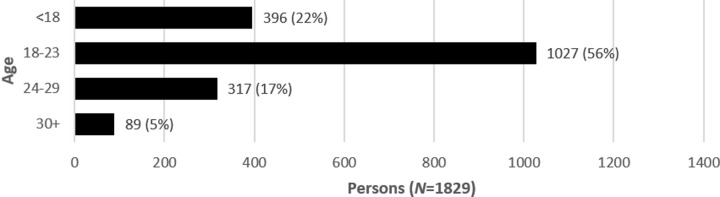
Age distribution.